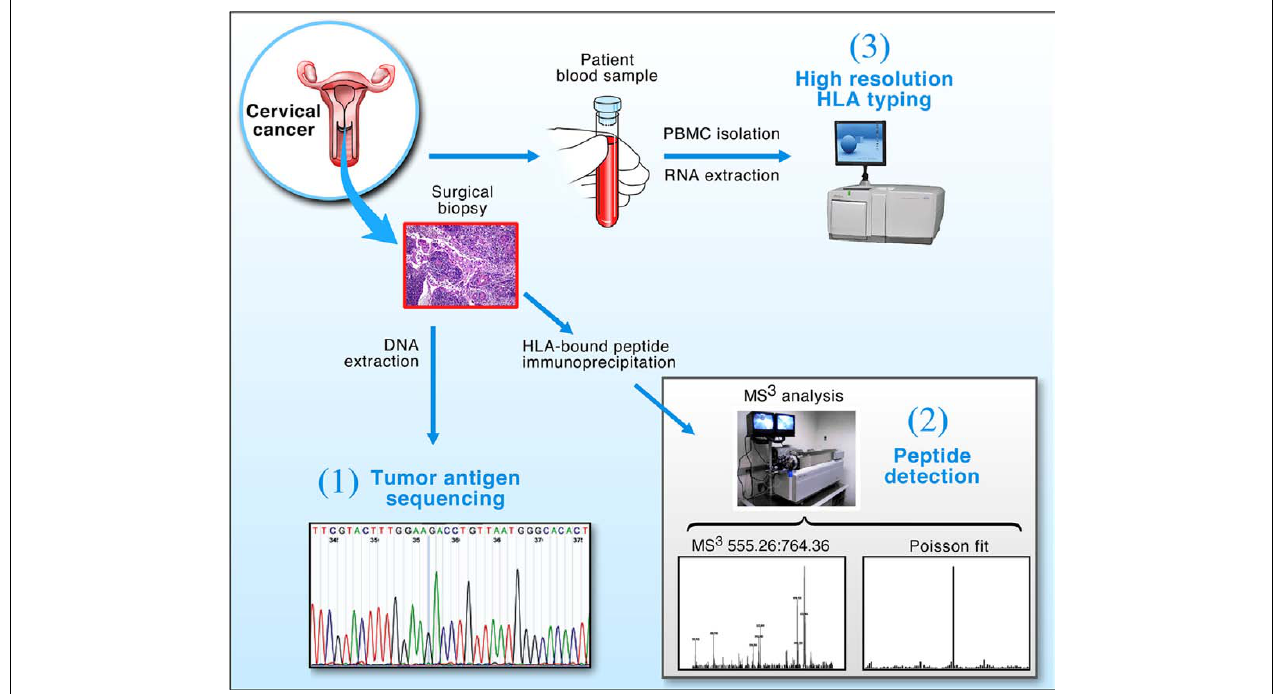
FIGURE 1 | Strategy for the detection of tumor antigens from clinical biopsy samples. Cervical cancer biopsy material and blood were obtained from patients and processed in three ways: (1)Tumor DNA was extracted and the E7 oncogene sequenced to determine its conservation; (2)The protein fraction from the tumor was used to extract peptide–HLA complexes for MS 3